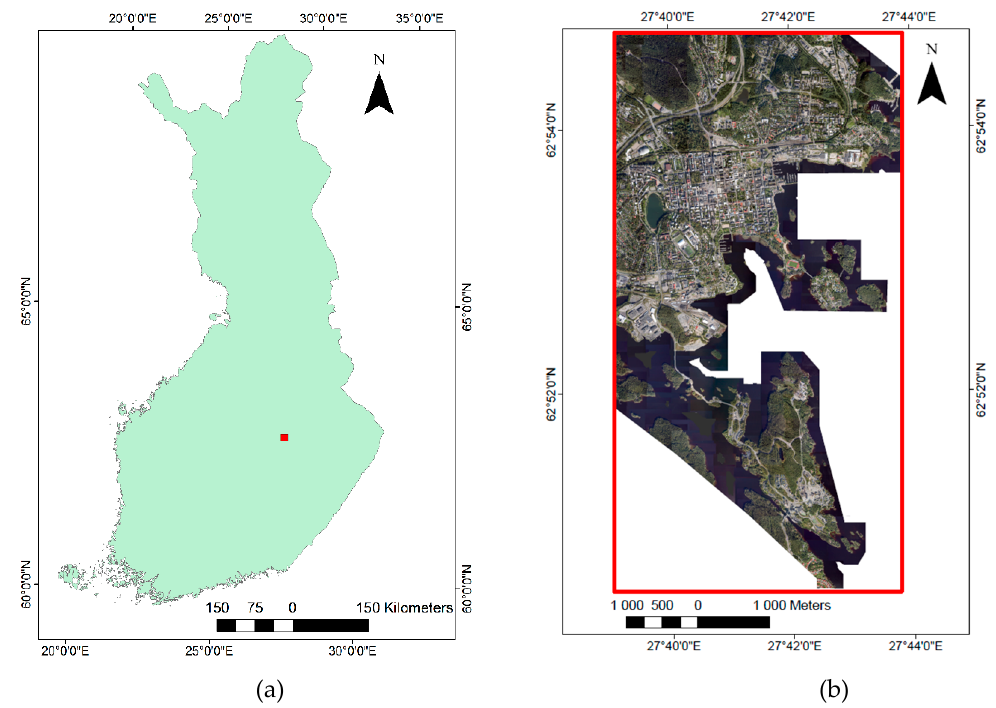
Figure 1. Location of the site used in this study is shown. ( a ) The location of the urban site of Kuopio city in Finland is marked with a red square. ( b ) The Kuopio study area is demarcated with a red polygon. An aerial image from 2014 is the background, where white color denotes ‘nodata’ areas. Adapted with permission [22].